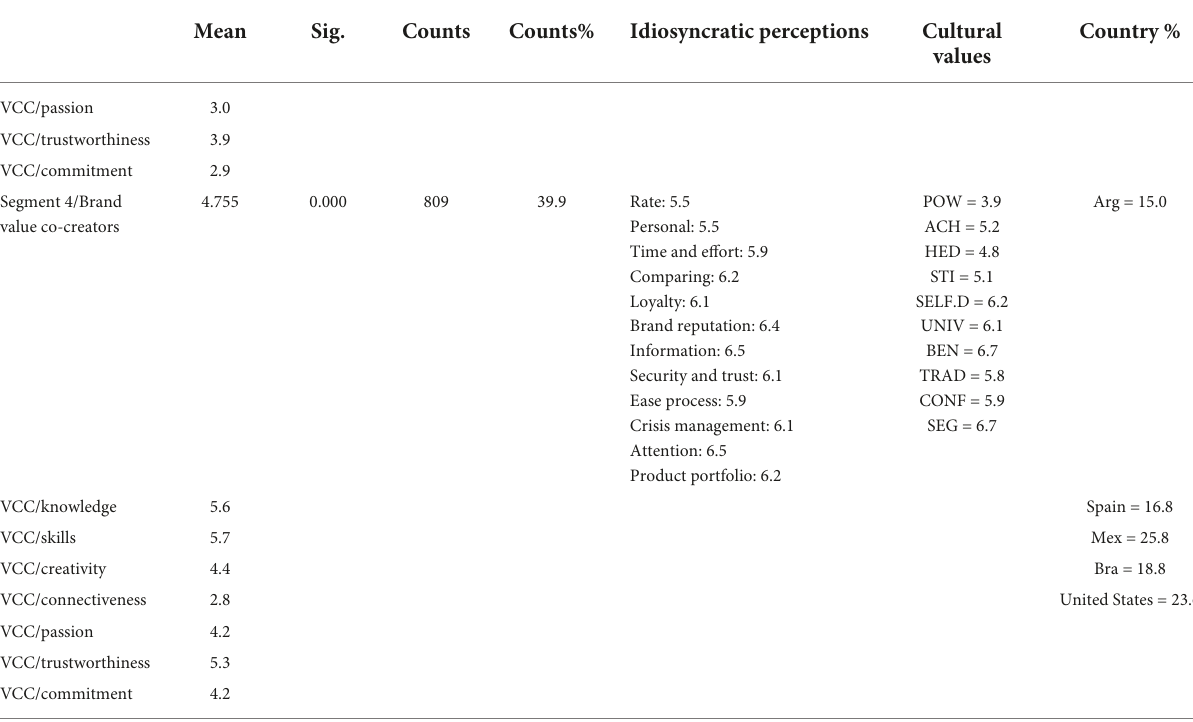
TABLE 5 Reliability and validity of the model. KNO SKL